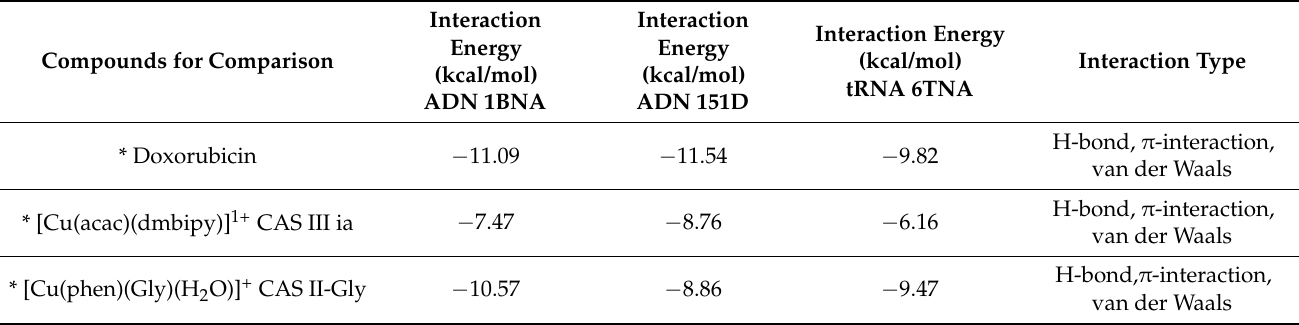
Table 3. Molecular docking results, including the binding energies for the best molecular poses of doxorubicin and reported complexes with DNA and